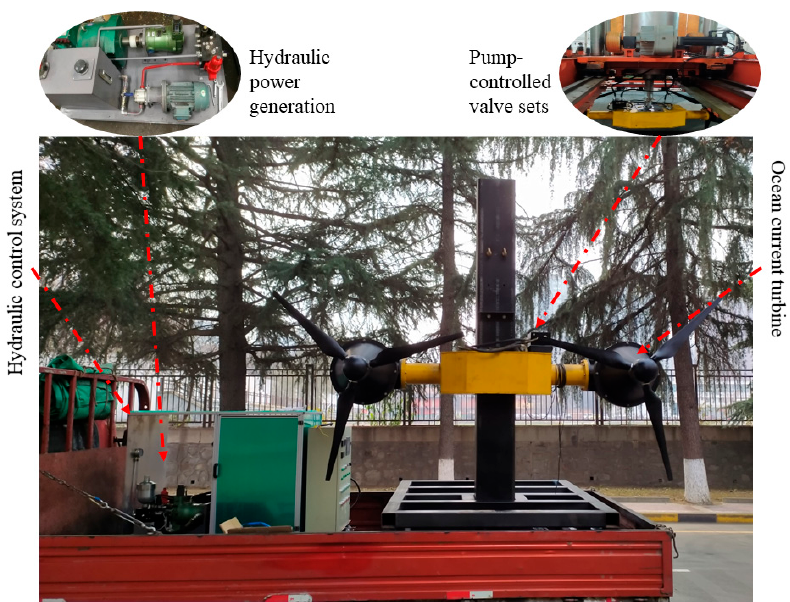
Figure 9. Assembly of ocean current turbine and hydraulic power generation control system.